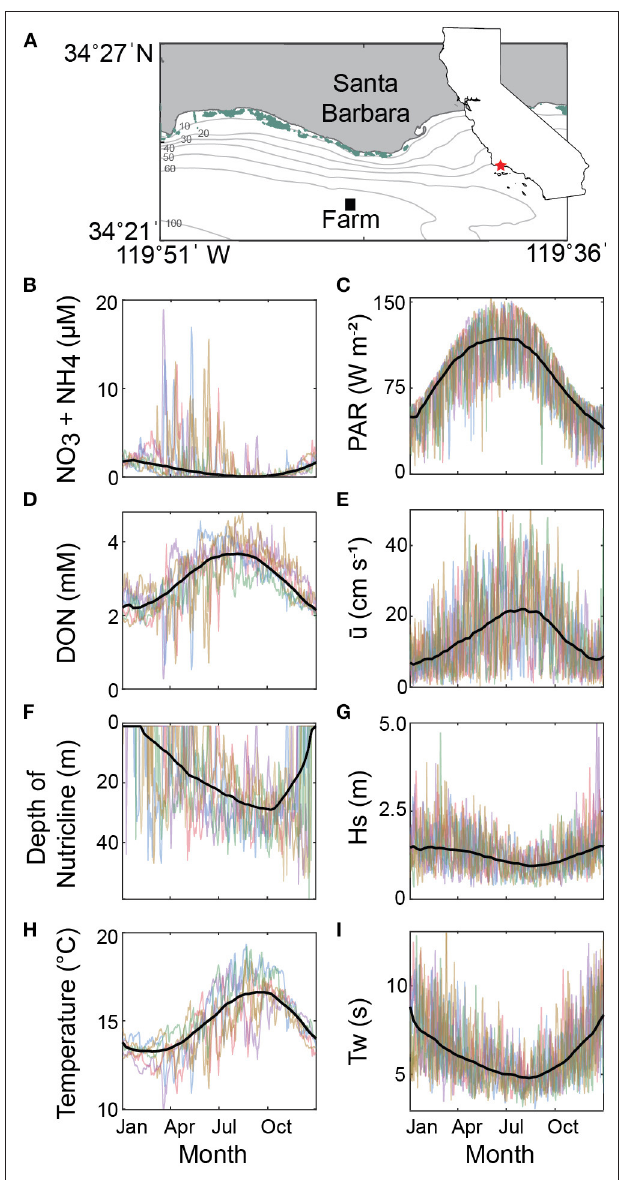
FIGURE 2 | (A) The simulated farm (black square) is located off Santa Barbara (red star in California inset) in 60-m water depth. Presence of kelp canopy from 2000–2005 along the Santa Barbara coastline as measured from Landsat satellite sensors indicated in green (data obtained from Santa Barbara Coastal LTER). (B–I) Synopsis of environmental input conditions to the macroalgal growth model predicted by the eddy-resolving oceanic physical-biogeochemical model (ROMS-BEC). Data plotted to illustrate seasonal trends and the high-frequency variability of these in time. Individual colored lines are single years (2000–2005) and plotted as daily averages within farming depths (surface to z cult ). Black thick lines are the daily mean across all years and smoothed. DON is dissolved organic nitrogen. Nutricline depth is the minimum depth at which NO 3 +NH 4 is greater than 1 µ M. PAR is the incoming photosynthetically active radiation just below the sea surface. ¯ u is the magnitude horizontal seawater velocity on the farm grid. H s is the significant wave height. T w is the average wave